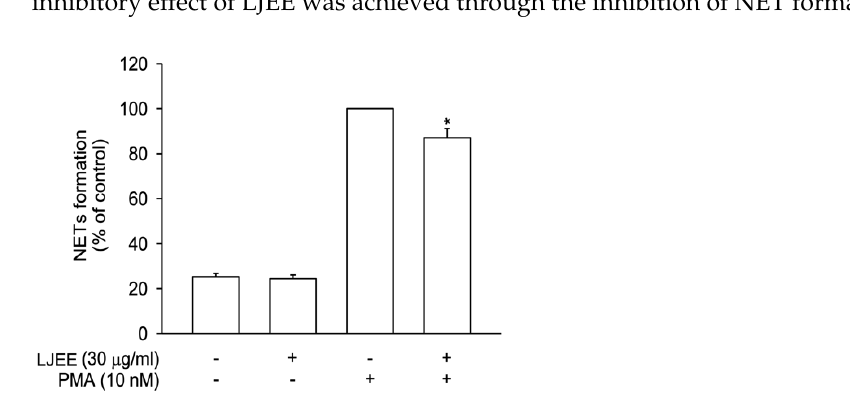
Figure 3. LJEE (30 µ g/mL) inhibited neutrophil extracellular traps (NETs) in phorbol 12-myristate 13-acetate (PMA)-stimulated human neutrophils. All data are expressed as the mean ± S.E.M. ( n = 6). * p < 0.05, as compared with the control group.